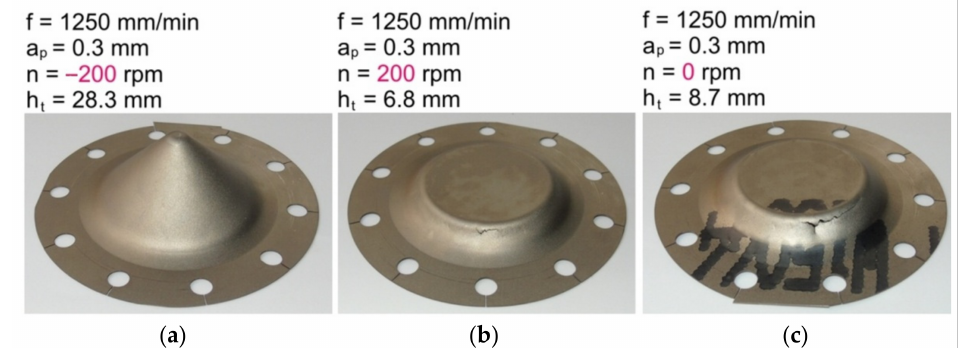
Figure 6. Drawpieces formed at a constant step size of 0.3 mm, tool feed rate of 1250 mm/min, and rotational speeds: ( a ) − 200 rpm; ( b ) 200 rpm; and ( c ) 0 rpm (freely rotatable tool).